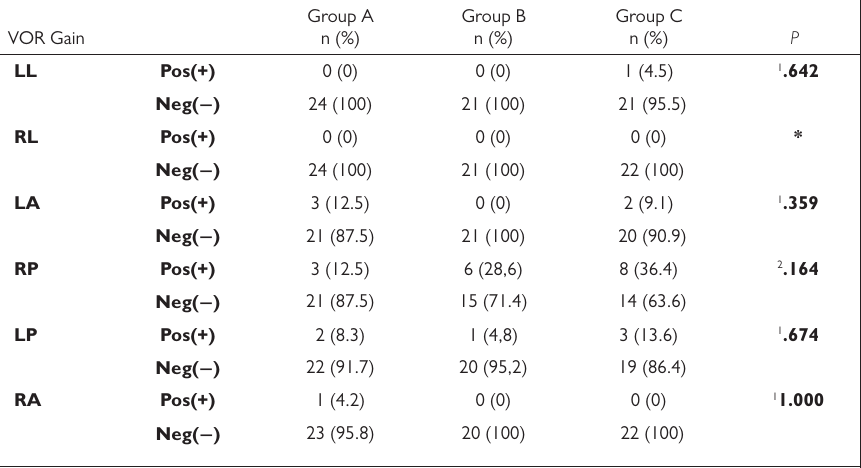
LL, left lateral semicircular canal; RL, right lateral semicircular canal; LA, left anterior semicircular canal; RP, right posterior semicircular canal; LP, left posterior semicircular canal; RA, right anterior semicircular canal; VOR, vestibulo-ocular reflex.